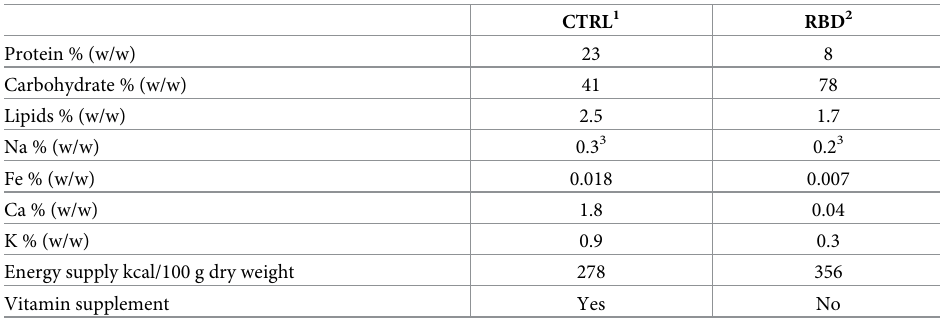
Table 1. Composition of